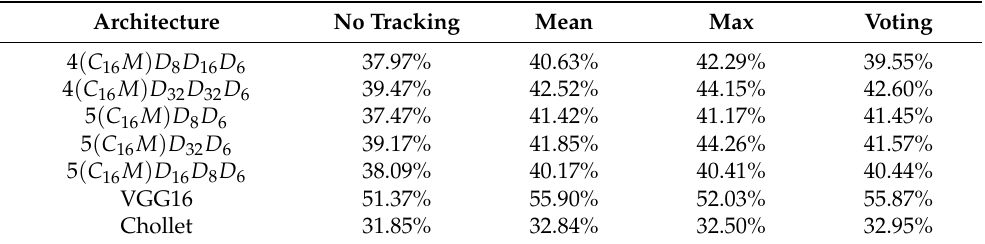
Table 4. Accuracy of the multi-class classification task with and without the tracking component. The Mean , Max and Voting columns refer to the type of decision scheme used when the tracking mechanism is applied. The dataset is divided into train, validation, and test subsets as shown in Table 2. The results shown are the mean of 3 realizations.